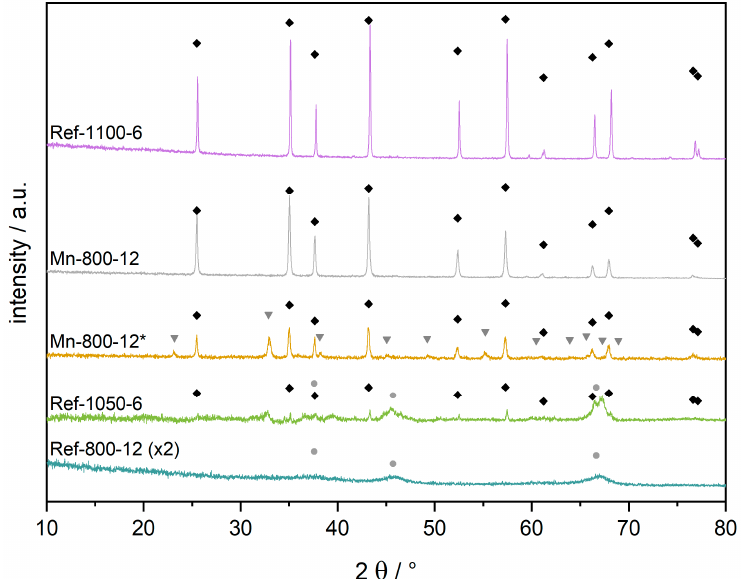
Figure 3. XRD patterns of sample Mn-800-12, calcined at 800 ◦ C for 12 h, before (yellow, marked *) and after (grey) removal of manganese species. For comparison, Mn-free reference samples are given at the top and bottom positions, calcined at 800 ◦ C and 1100 ◦ C, respectively. The pattern of reference sample Ref-800-12 is expanded ( × 2) for better visibility. Black rhombs mark corundum reflexes, gray triangles show bixbyite (Mn 2 O 3 ), and light gray circles indicate the major reflexes of γ -Al 2 O 3